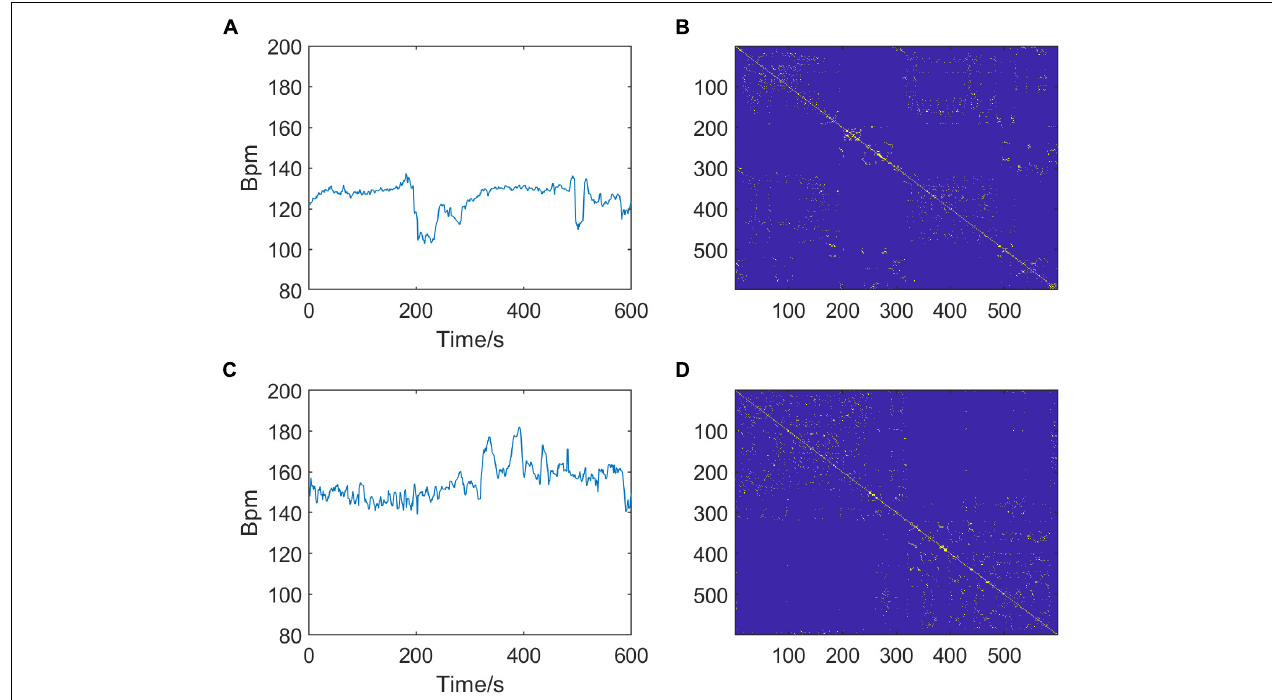
FIGURE 3 | Preprocessed fetal heart rate (FHR) signals (left, A,C ) and corresponding recurrence plots (RPs, right, B,D ) of normal (top, A,B ) and pathological fetuses (bottom, C,D ). The RP parameters are m = 2, τ = 1, and k =